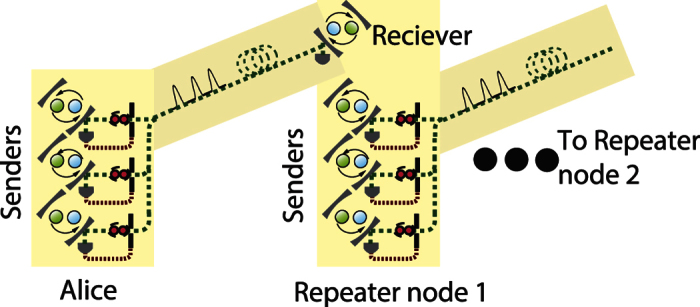
Schematic diagram of a spatially asymmetric multiplexed quantum repeater scheme19.